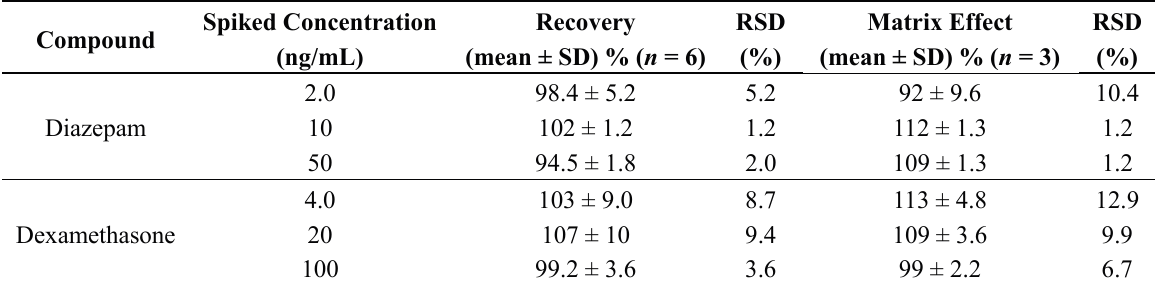
Table 2. The recovery and matrix effect of diazepam and dexamethasone in rat plasma. Spiked Concentration Compound